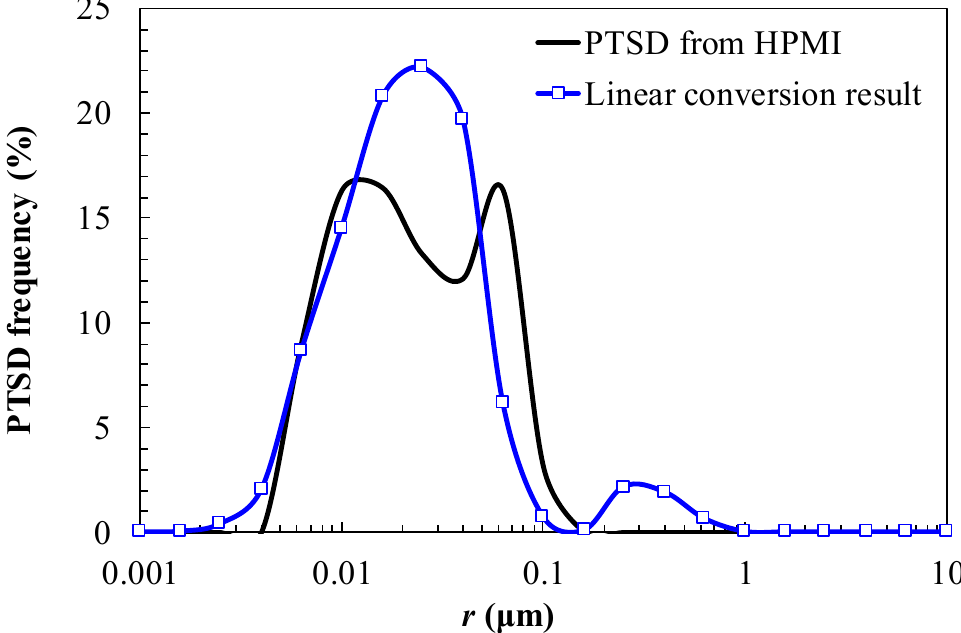
Figure 8. Comparison between the converted PTSD from NMR T 2 spectra and the measured PTSD from HPMI for Z39.